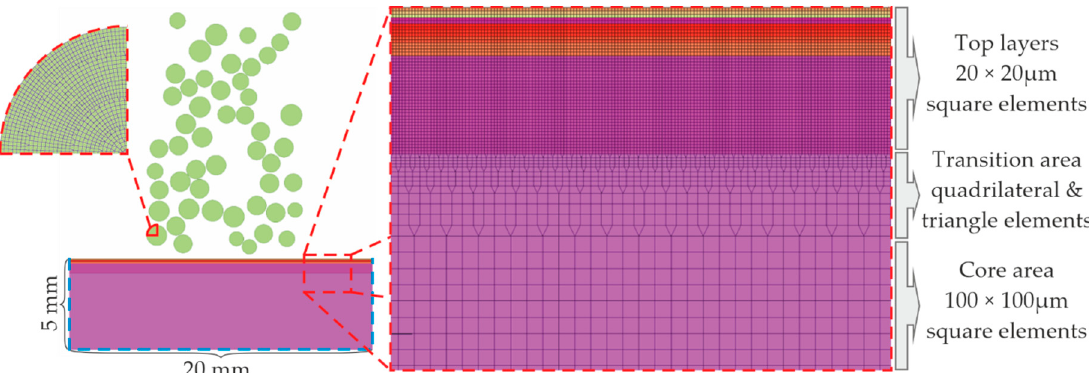
Figure 2. Specimen discretization strategy.